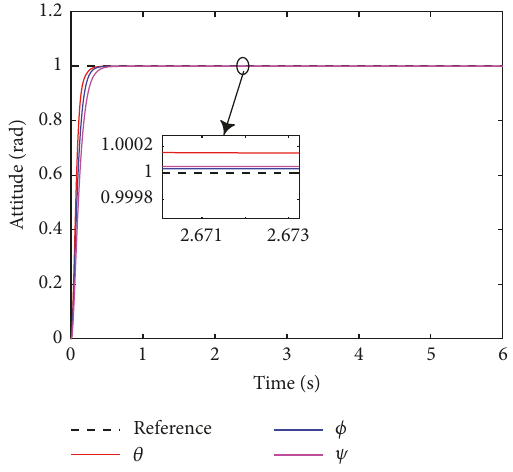
Figure 5: Response of the attitude.